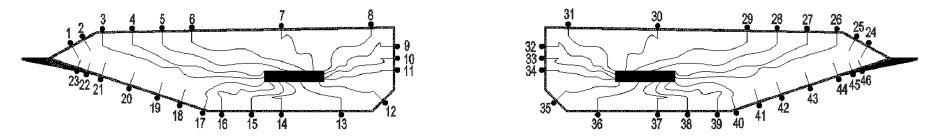
Figure 3. Location of the pressure taps in the section circumference.